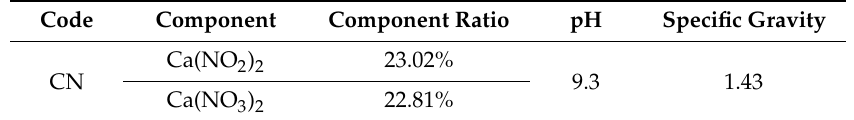
Table 2. Properties of the anti-freezing agent.